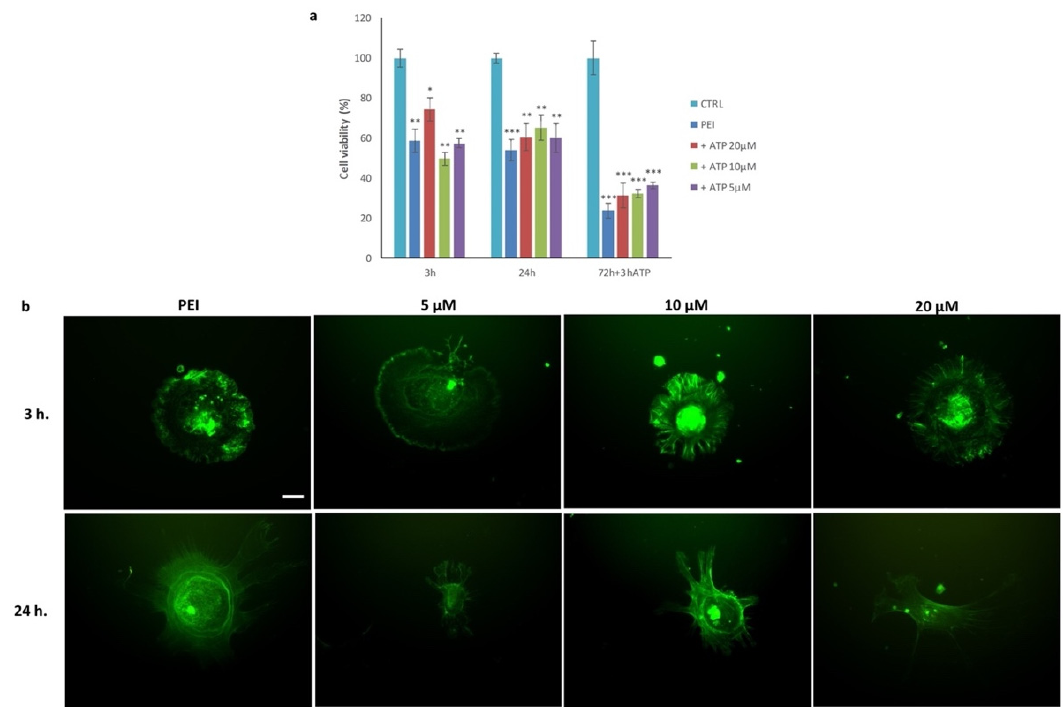
Figure 10. Effects of exogenous ATP on viability and microfilaments. ( a ) Values of the MTT assay are derived from the average of three experiments and expressed as percentages referring to the control; * p < 0.05, ** p < 0.01 and *** p < 0.001 versus CTRL (one-way ANOVA). ( b ) Representative images of actin cytoskeleton after 3 and 24 h of culture in medium supplemented with different concentrations of ATP; green represents FITC-conjugated antibody stain of FAK scale bar: 5 μ m (for all the images shown).